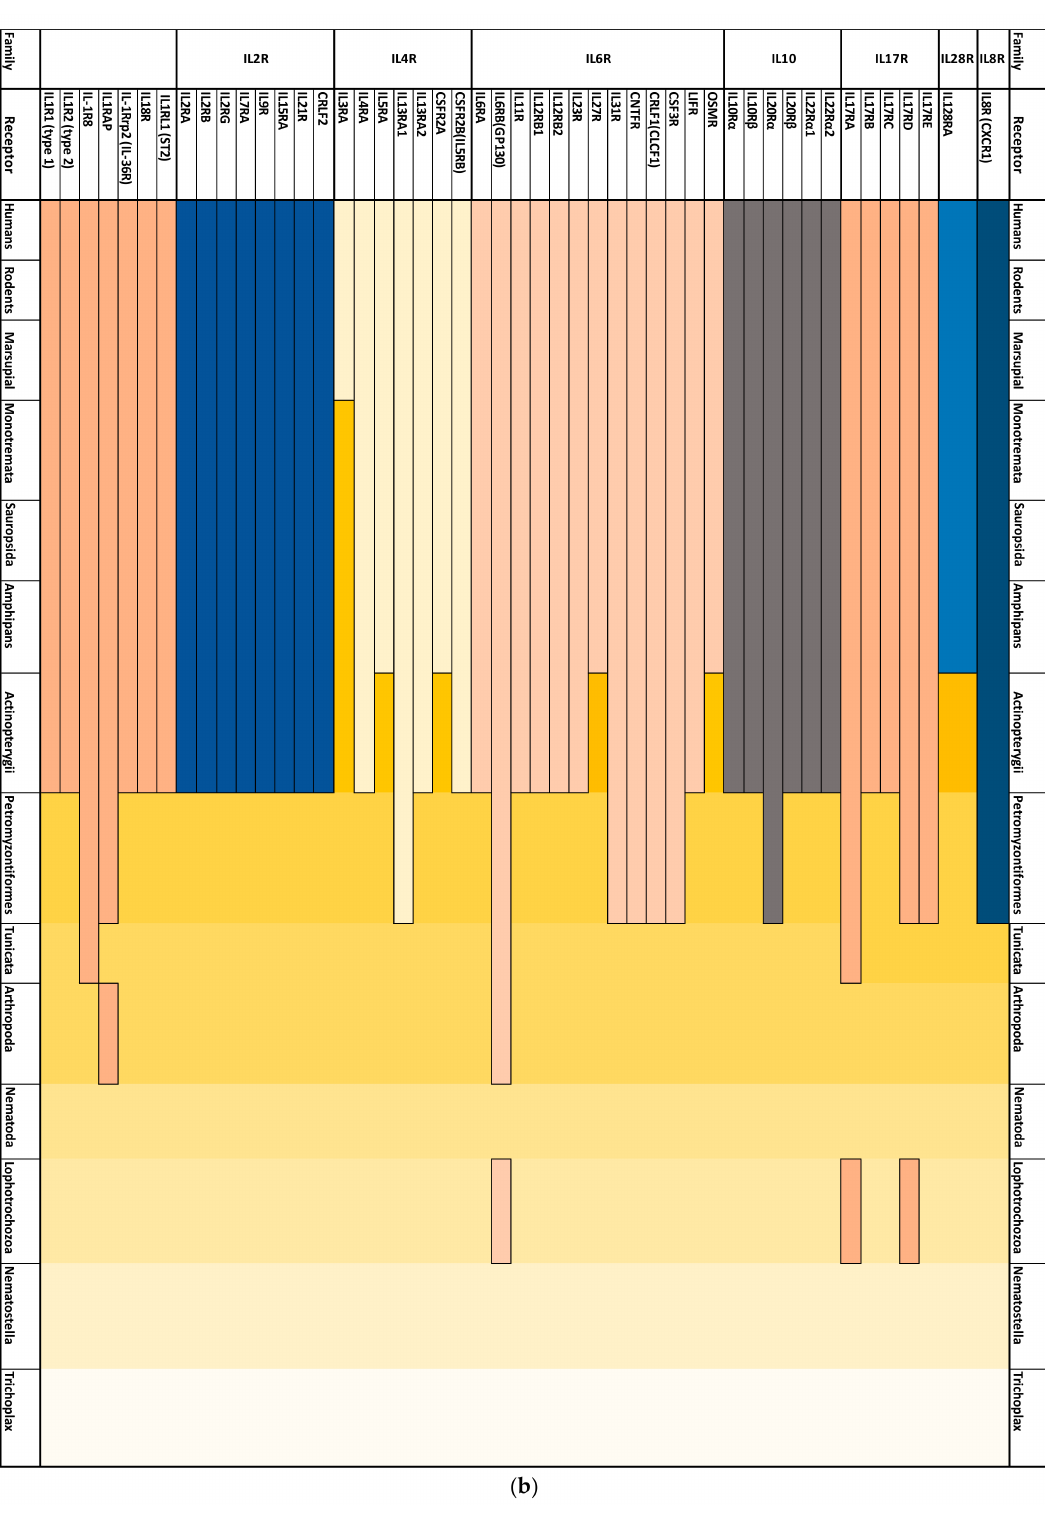
Figure 2. Evolutionary history of ILs and their receptors. ( a ) Interleukins evolutionary history; the most ancient member of ILs is IL14, which first appeared in Trichoplax and has an orthologs in Fungi. IL1B and IL17A, which both play critical roles in T cell function, first appeared in lampreys. Interestingly, IL6R appears in Drosophila. However, IL6 does not seem to have appeared in this species. ( b ) Interleukin receptors evolutionary history. IL17AR and IL17DR first diverged in Mollusca. IL-1R8 and IL1RAP first appeared in lampreys, together with IL13RA, IL6RB(GP130), CNTFR, clcf1(CRFL1), IL20R α IL17R, and IL8R. As lampreys possess VLAR, VLARB, and VLARC cells and not T cells, IL1B and IL6, as well as these receptors, could be performing distinctive roles in this